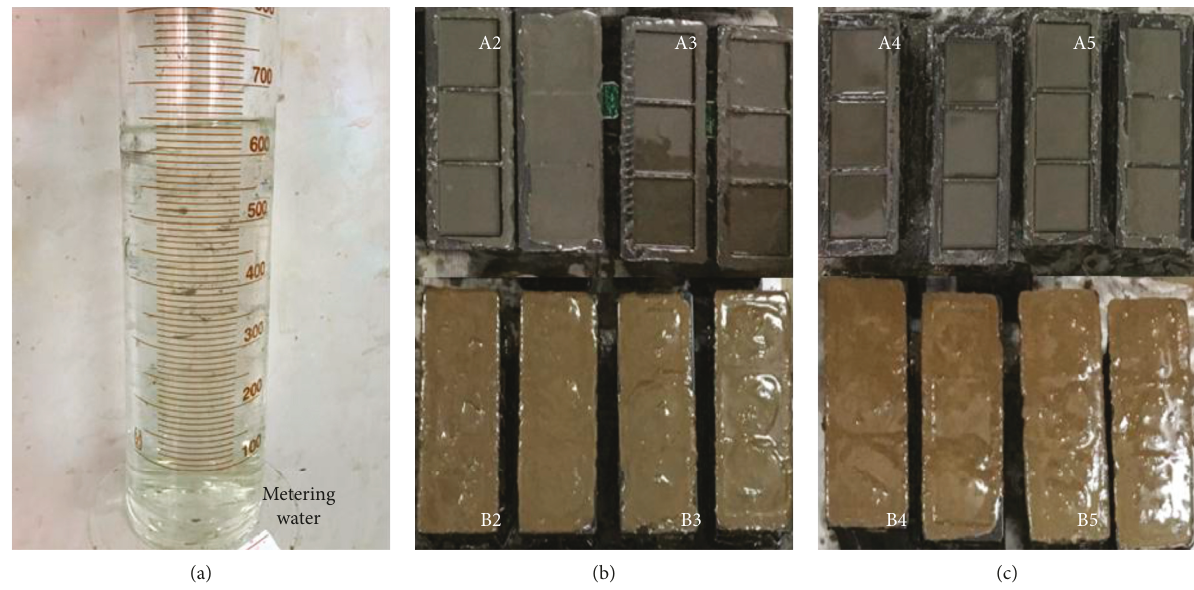
Figure 5: Production process for the backfill (including metering water and backfilling paste).